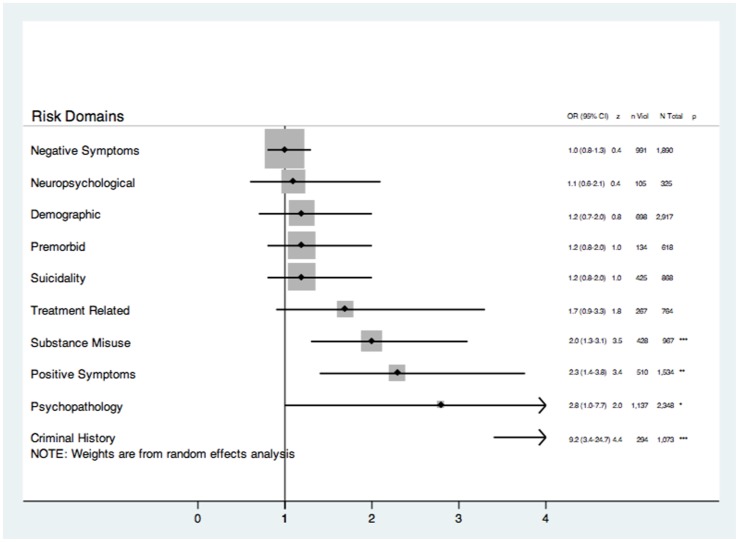
Risk of violence in psychosis reported as odds ratios (ORs) according to ten overall psychosocial and clinical domains for those studies conducted in predominately inpatient settings rather than predominately outpatient or mixed patient settings (k = 34).
n Violent = number of violent participants, N Total = total number of participants, *** = significant to the <0.001 level, ** = significant to the 0.01 level. * = significant to the 0.05 level. Factors ranked according to pooled OR magnitude.